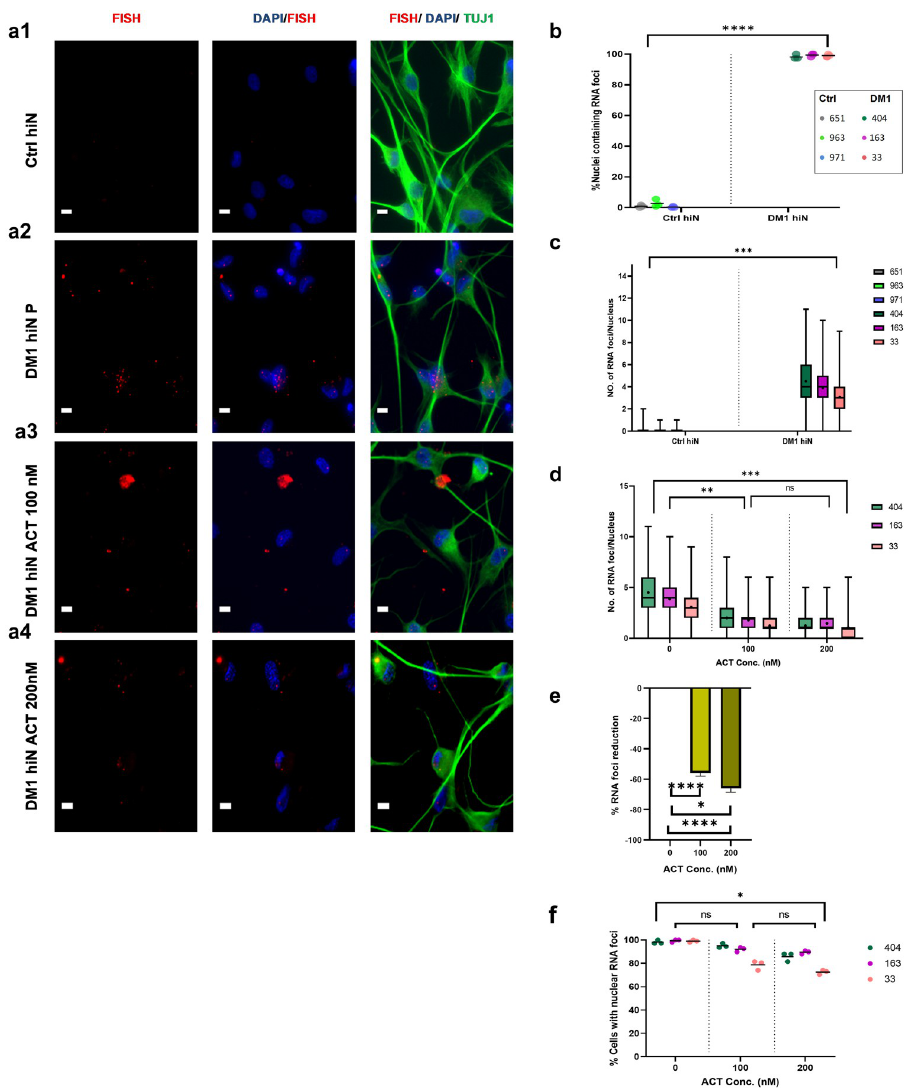
Fig 4. Accumulation of nuclear RNA foci in DM1 hiNeurons at 10 DPI and their reduction by ACT treatment. (a) FISH with 5’ Texas red 2-O-methyl- CAG RNA probe and immunostaining with TUJ1 and DAPI revealed punctate and discrete nuclear RNA foci (red) in DM1 hiNeurons (a2) but not in control hiNeurons (a1). Nuclear RNA foci were abundant in DM1 hiNeurons (a2) but treatment with 100 nM (a3) or 200 nM (a4) ACT reduced them remarkably (left: FISH, middle: merged images of FISH and DAPI staining nuclei (blue), right: merged images of FISH, DAPI and TUJ1 antibody staining neurons (green)). Scale bar, 20 μ m. (b) Scatter plot shows percentage of nuclei containing RNA foci in DM1 hiNeurons. Each sample is presented in different color. Each symbol represents the percentage of nuclei containing RNA foci for each sample replicate. Line represents the mean. Note that nuclear RNA foci were present in most of DM1 hiNeurons. (c) Box and whisker plot shows number of RNA foci per nucleus in DM1 hiNeurons. Each sample is presented in different color. Line and (+) sign inside the box represent median and mean of replicates (outcome analyzed), respectively. Whiskers show minimum & maximum values. Counting was performed manually. n = 3 for each group, a total of 324 nuclei were analyzed per sample. ���� P < 0.0001 and ��� P < 0.001 compared to control group by unpaired t-test. (d) Box and whisker plot displays the results of nuclear RNA foci count in placebo and ACT treated DM1 hiNeurons. Each sample is presented in different color. Line and (+) sign inside the box represent median and mean of replicates (outcome analyzed), respectively. Whiskers show minimum & maximum values. Note that the maximum number of nuclear RNA foci in placebo treated DM1 hiNeurons is 11 whereas treatment with 100 nM or 200 nM ACT reduced that number to 8 or 6, respectively. (e) Graph shows percentage of nuclear RNA foci reduction in DM1 hiNeurons by ACT treatment. Nuclear RNA foci count was reduced by 56% or 66% in 100 nM or 200 nM ACT treated DM1 hiNeurons, respectively. The reduction percentage is calculated according to Eq (1). (f) Scatter plot shows percentage of nuclei containing RNA foci in placebo and ACT treated